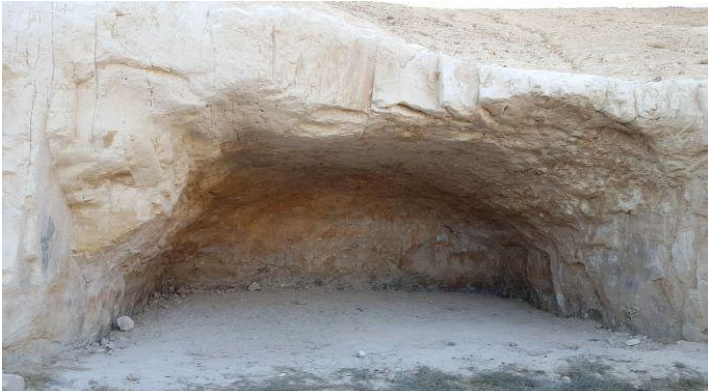
Figure 7. Bir Umm al Atin Cistern, Al Baqi’a valley. Cisterns, which were commonly located in the vicinity of the settlements, served as the site for a series of mediating actions in 2019–2020. Cisterns and water tanks are an ancient phenomenon that have provided for desert dwellers for millennia. Photographed by Dan Farberoff. Image courtesy of the artist.